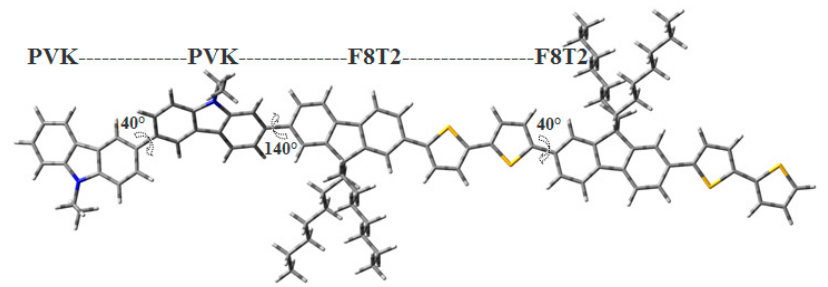
Figure 2. Chemical structure proposed for the PVK-F8T2 copolymer.